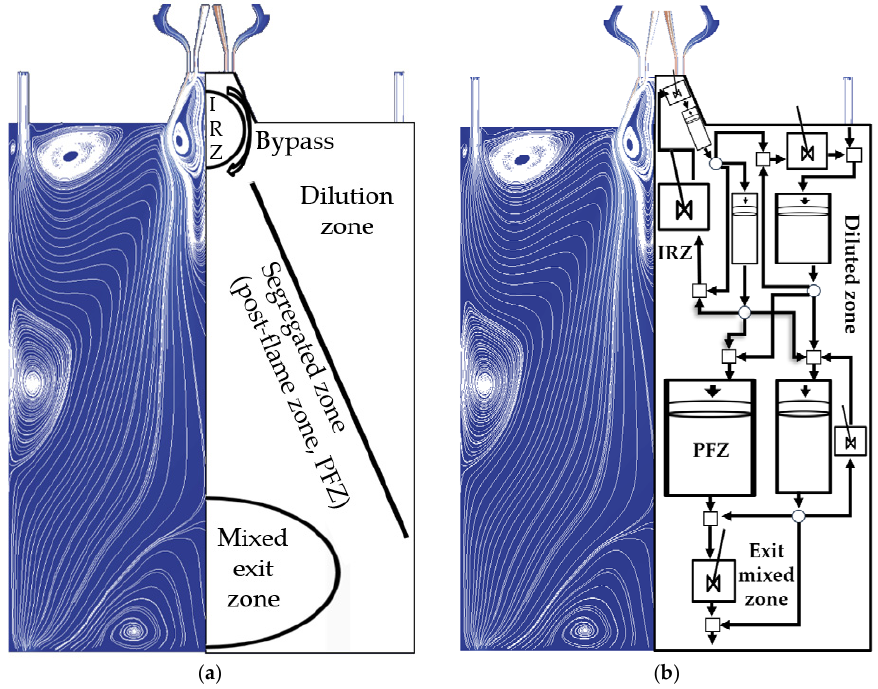
Figure 3. Streamlines extracted from CFD calculations of the mean flow field for non-reacting, air-oxidized conditions [56]. ( a ) gross schematization highlighting the main mixing zones is superimposed to the streamlines; ( b ) CRN model of the combustor.